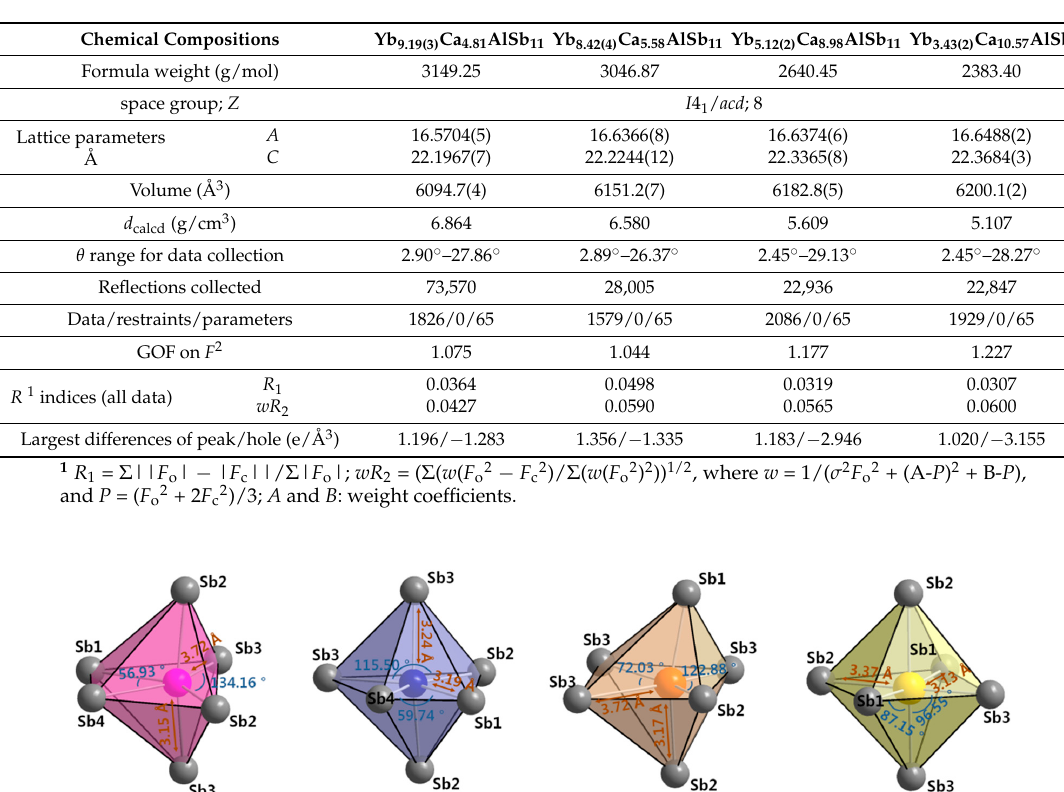
(4.81(3) ď x ď 10.57(2)) series.